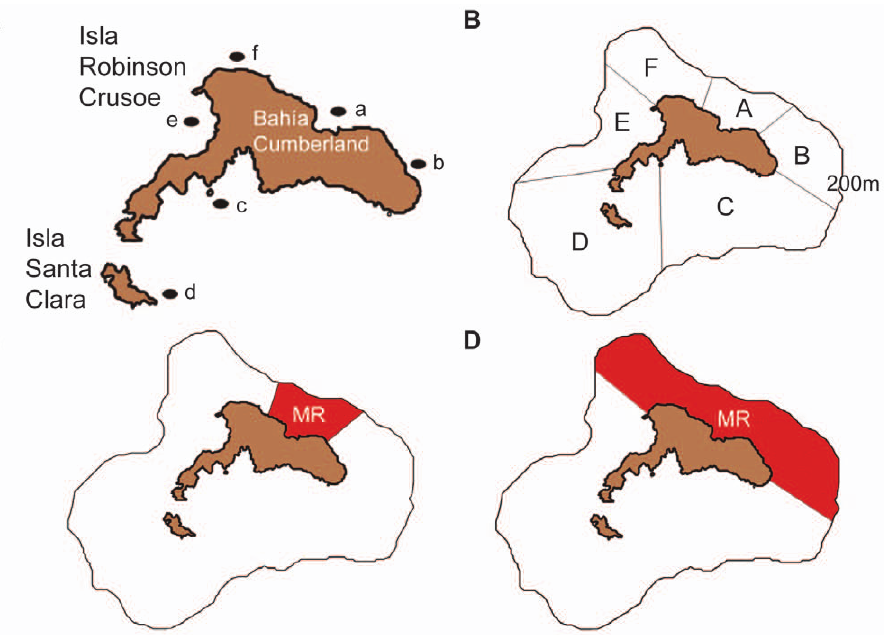
Figure 3. Map showing underwater survey locations, spatial regions and MR locations. A – Map of Islas Robinson Crusoe and Santa Clara showing the main fishing port of Bahı´a Cumberland and underwater survey locations (a–f; see Table 1 for names). B – Spatial regions used in model scenarios (A–F) with 200m depth contour. C – Location of 10% MR used in model scenarios. D – Location of 30% MR used in model scenarios.